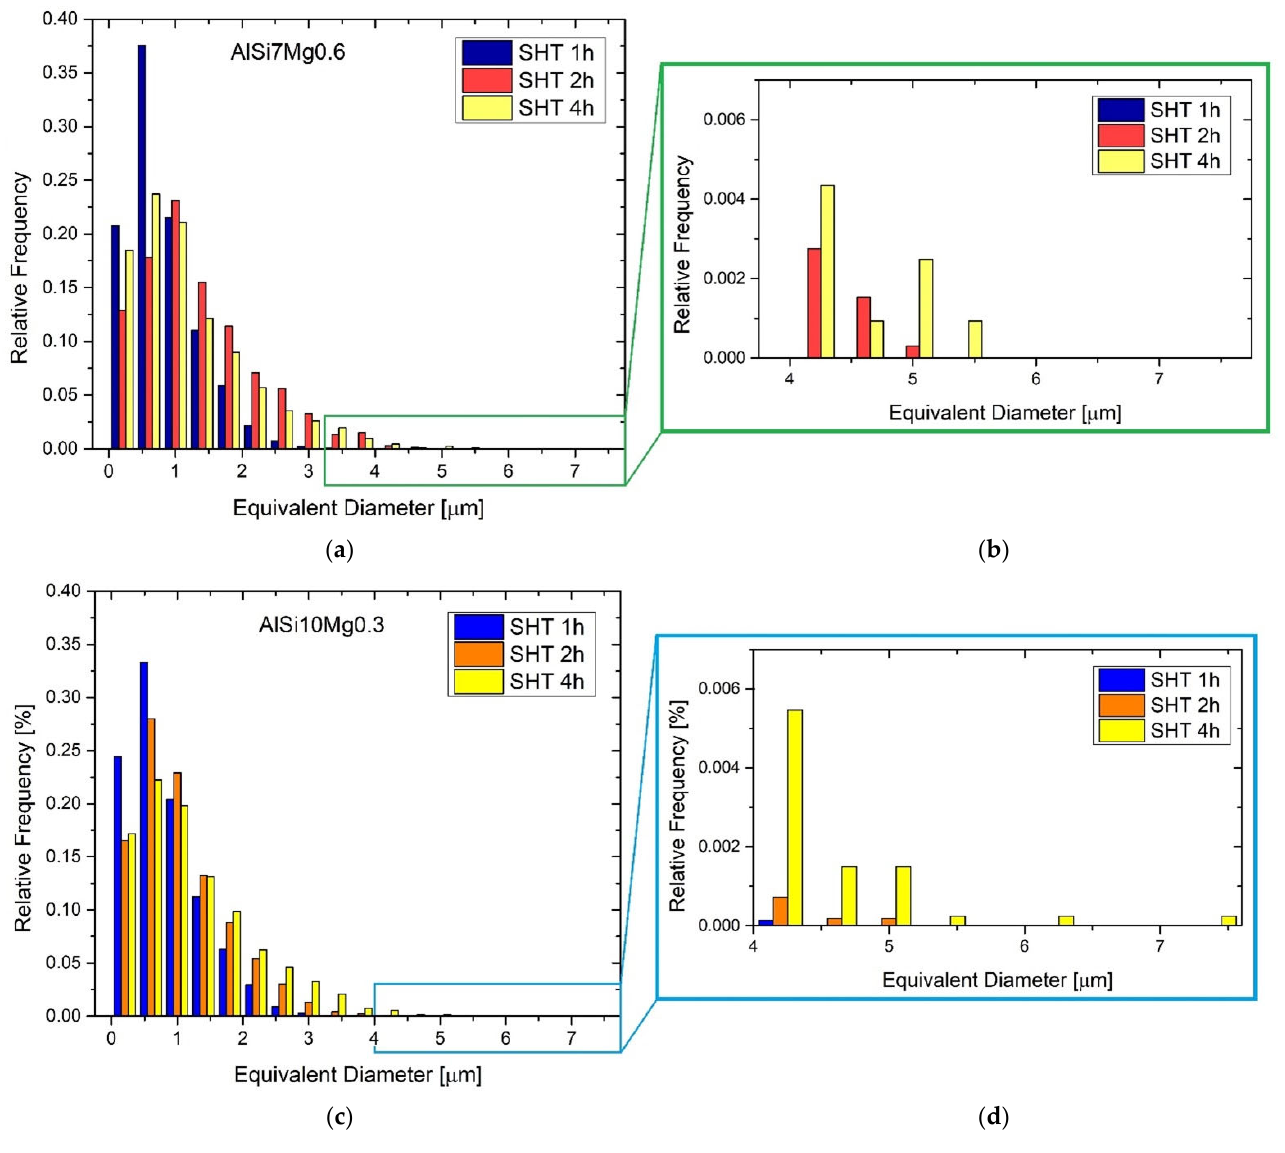
Figure 8. Statistical analysis of the equivalent diameter of the Si ‐ eutectic particles analysed on: ( a , b ) AlSi7Mg0.6 and ( c , d ) AlSi10Mg0.3 samples solution heat treated at 505 °C × 1 h, 2 h and 4 h. The graphs in panels ( b , d ) are the magnifications of the same graphs in ( a , c ). Top AlSi10Mg0.3 samples (Figure 10c) DA at 175 ◦ C, 200 ◦ C and 225 ◦ C × 0.5–16